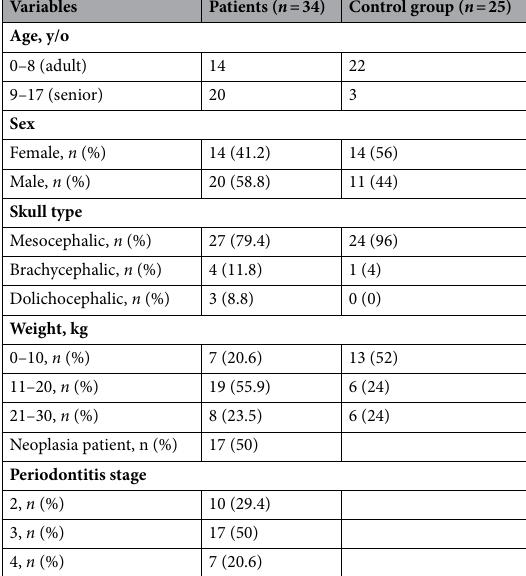
Table 1. Characteristics of the control group and canine periodontitis and neoplasia group.